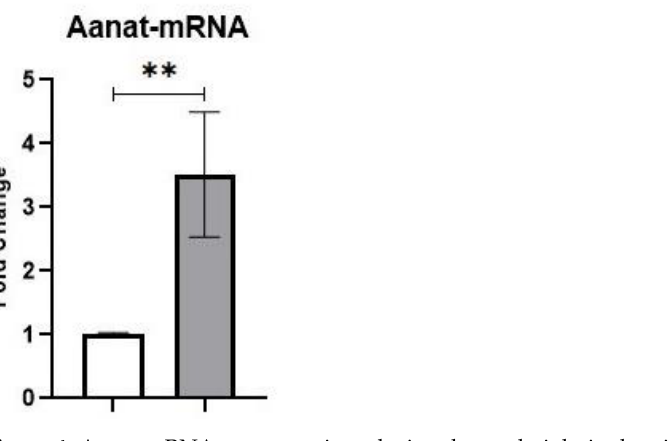
Figure 4. Aanat mRNA concentrations during day and night in the pineal glands of nonblasted rats. Results are expressed as means ± SEM (n = 6); ** p < 0.01 in comparison with samples collected during